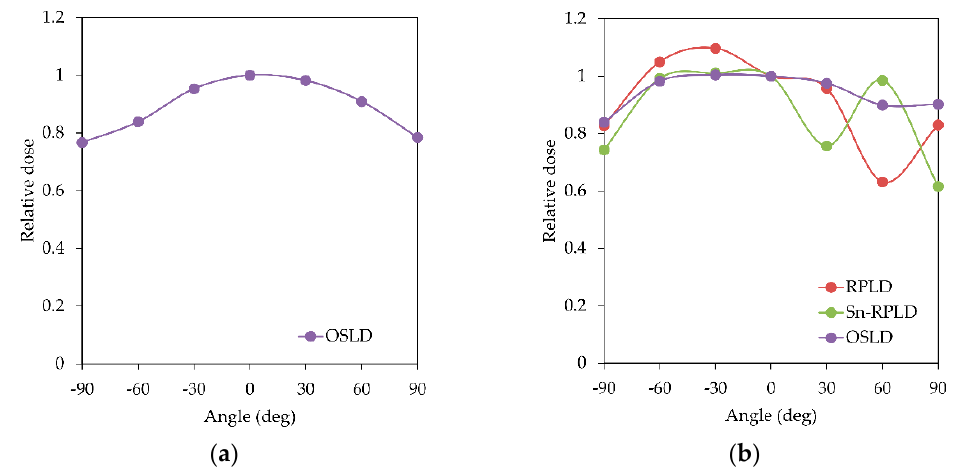
Figure 6. Sensitivity of small dosimeters as a function of effective energy: ( a ) additional filter of 0.2 mmCu and ( b ) addi- tional filter of 0.3 mmCu.